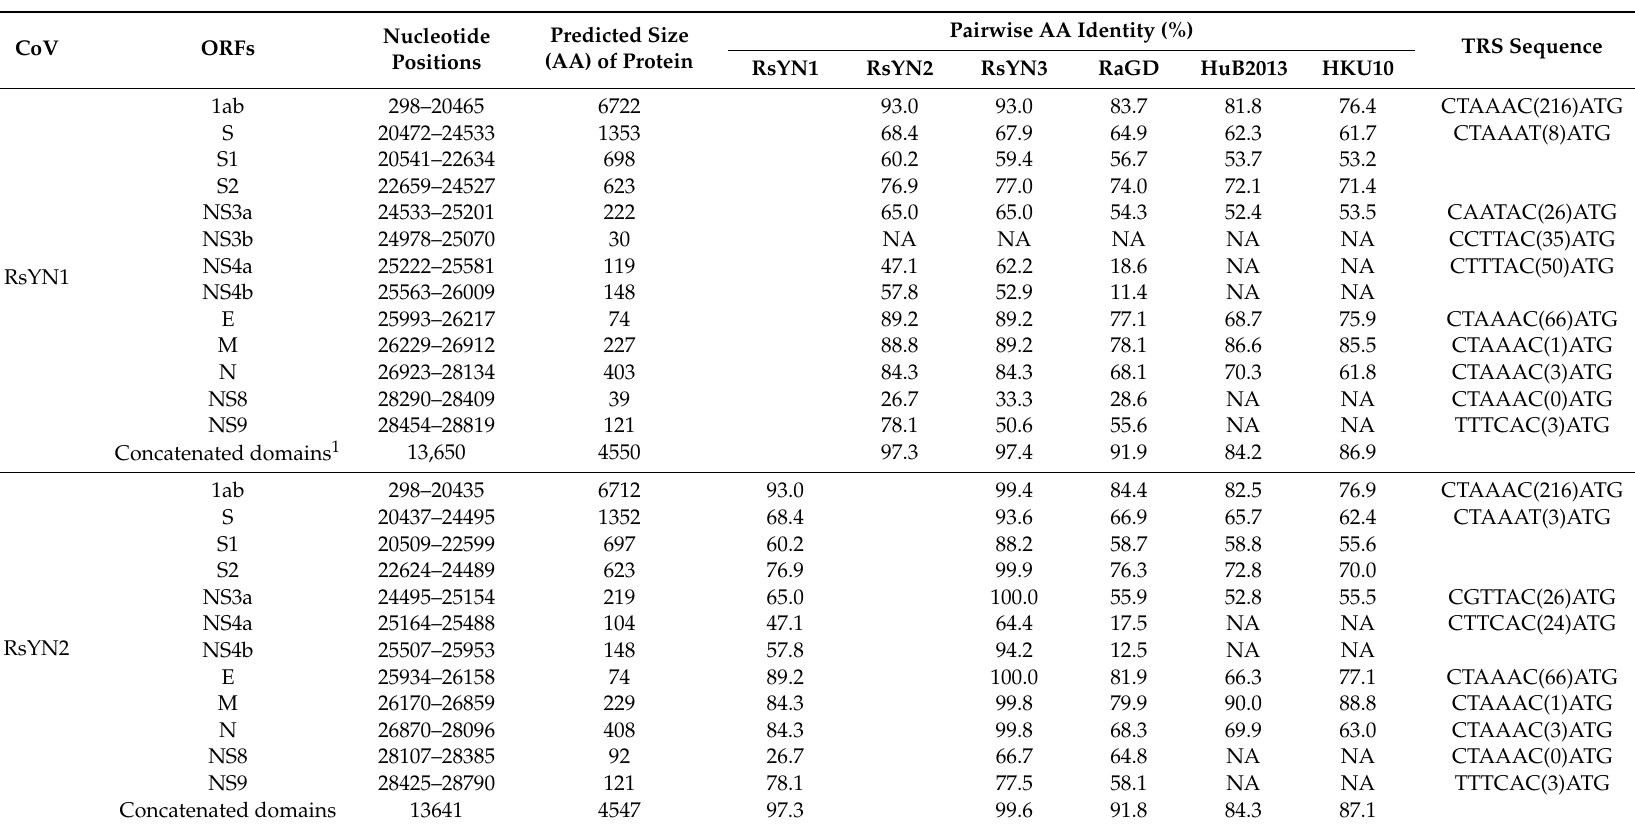
Table 2. Comparison of coding regions, TRSs, and whole genome of BtCoV / Rh / YN2012 and with BtRf AlphaCoV / HuB2013 (HuB2013) and Ro-BatCoV HKU10